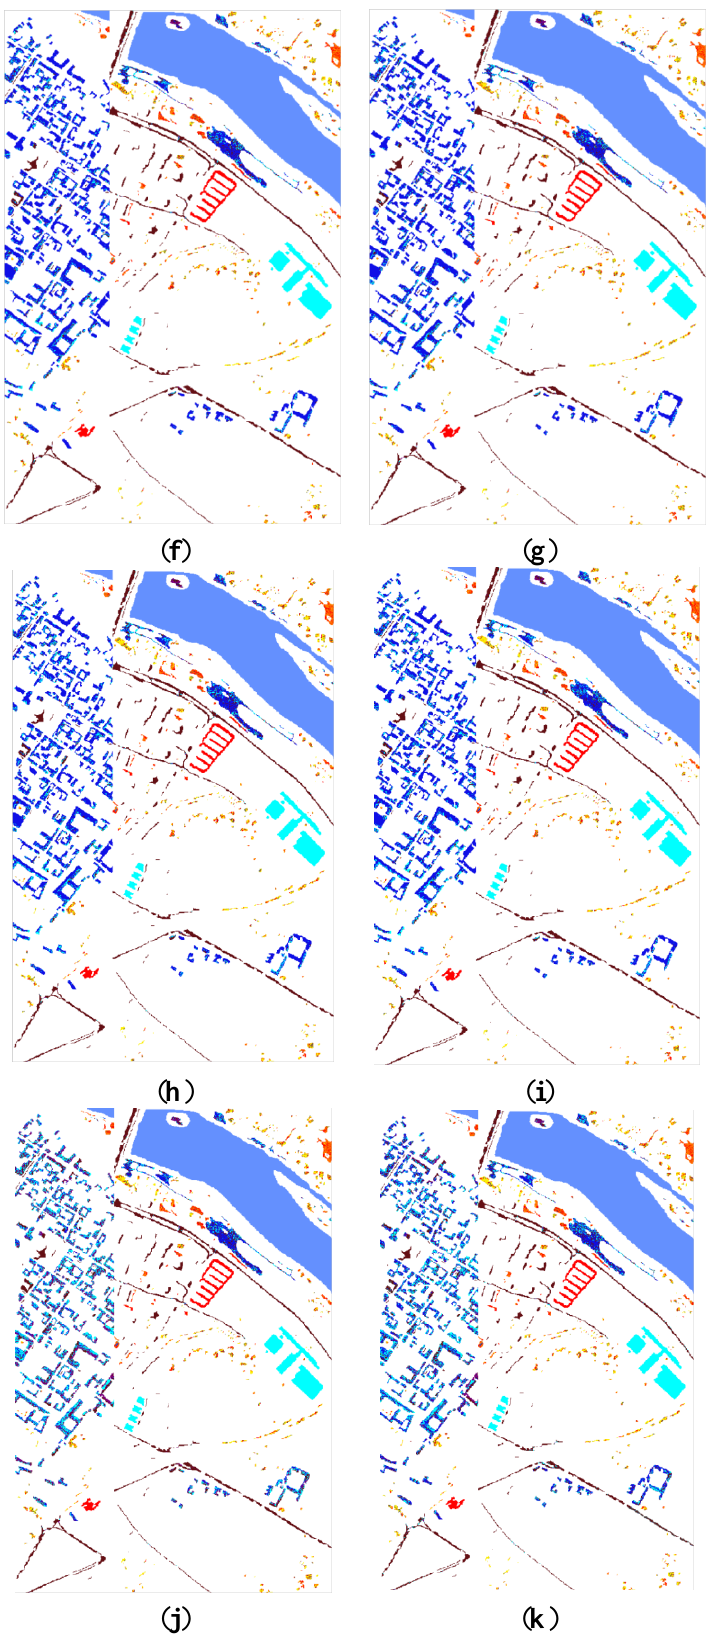
Figure 8. The classification maps of dataset Pavia City Center using various algorithms: ( a ) The ground truth, ( b ) FKNFLE; ( c ) KNFLE; ( d ) FNFLE; ( e ) NFLE; ( f ) NRS; ( g ) LFDA- NRS; ( h ) LFDA; ( i ) supervised LPP; ( j ) LDA; and ( k )